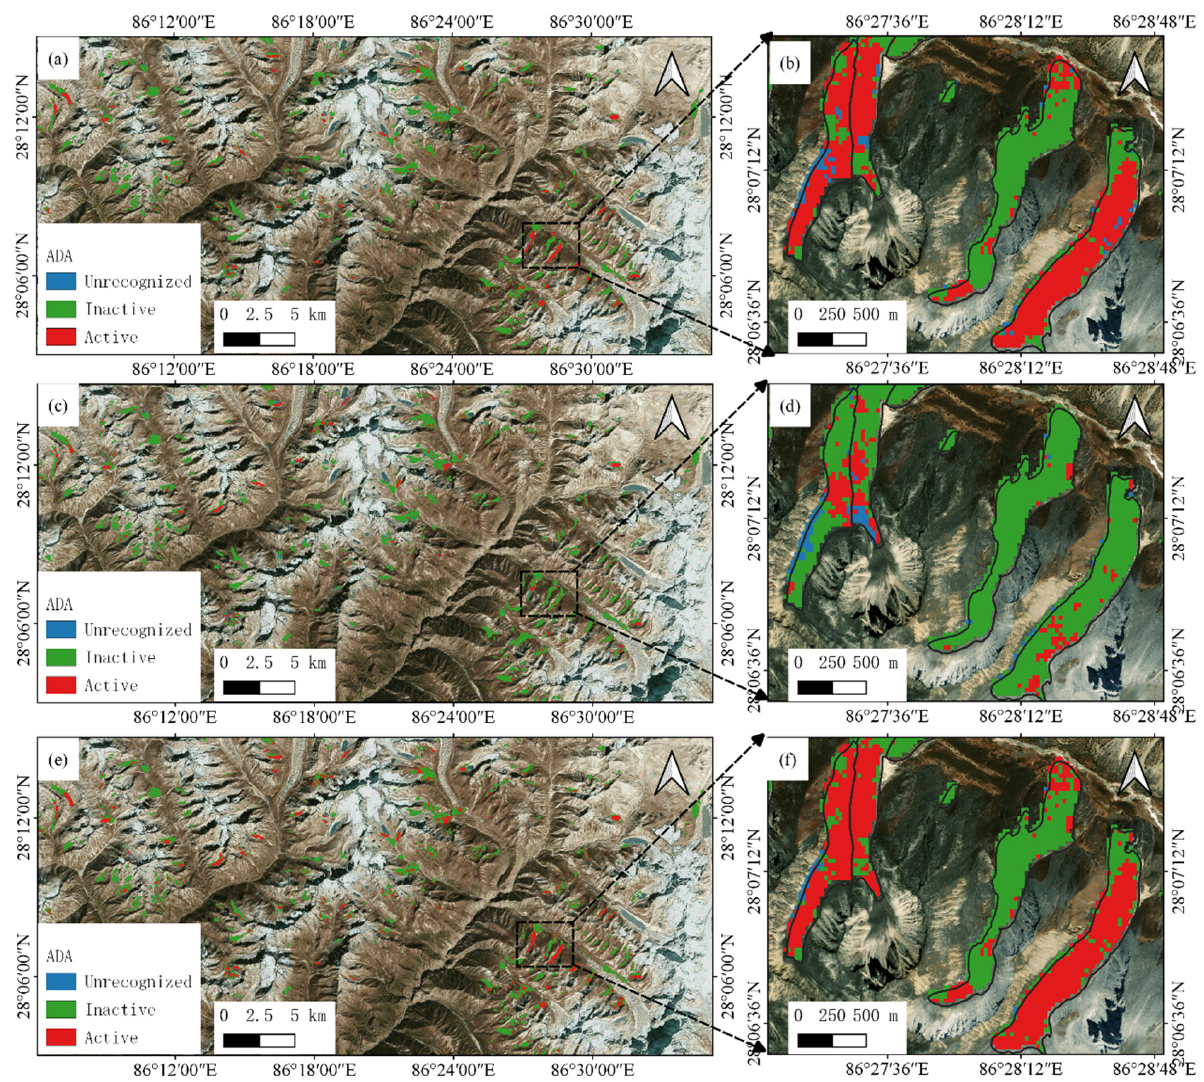
Figure 12. The active deformation area (ADA) extraction results in different zoom-in scales over a part of the central Himalayas. ( a , b ) The ADA map in ascending geometry on a different scale. ( c , d ) The ADA map in descending geometry on a different scale. ( e , f ) The ascending and descending ADA merging results on a different scale.